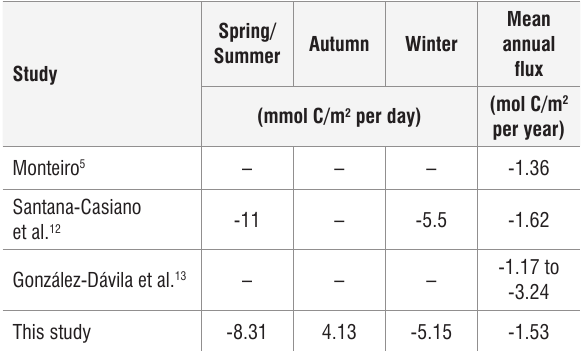
Table 1: Air–sea fluxes reported in previous studies and found in